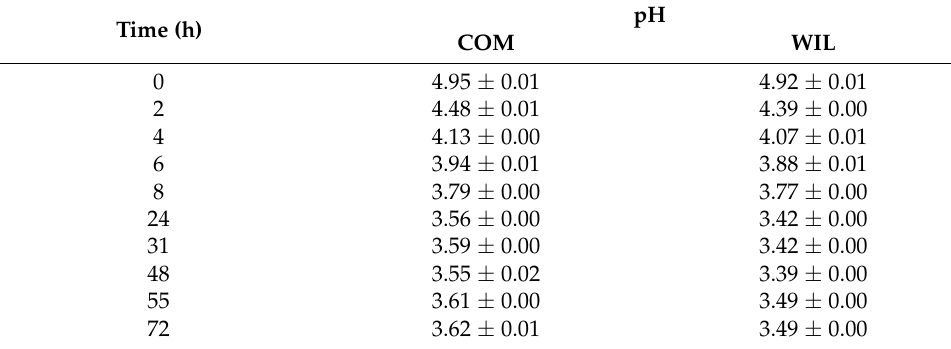
Table A1. pH values throughout the fermentation of Habanero